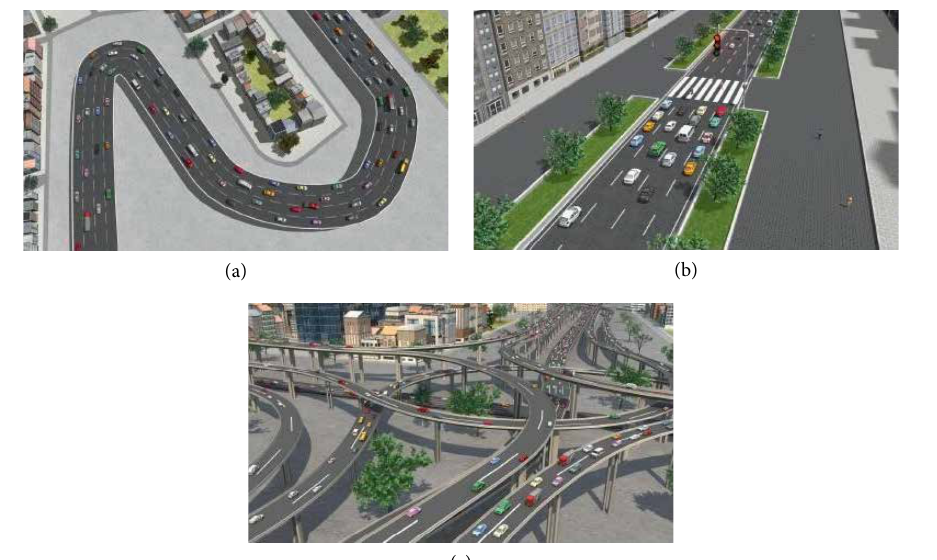
Figure 2: The synthesized traffic flows. (a) The synthesized traffic flows on a curvy road. (b) The synthesized traffic flows on a traffic-light controlled road. (c) The synthesized traffic flows on an urban highway